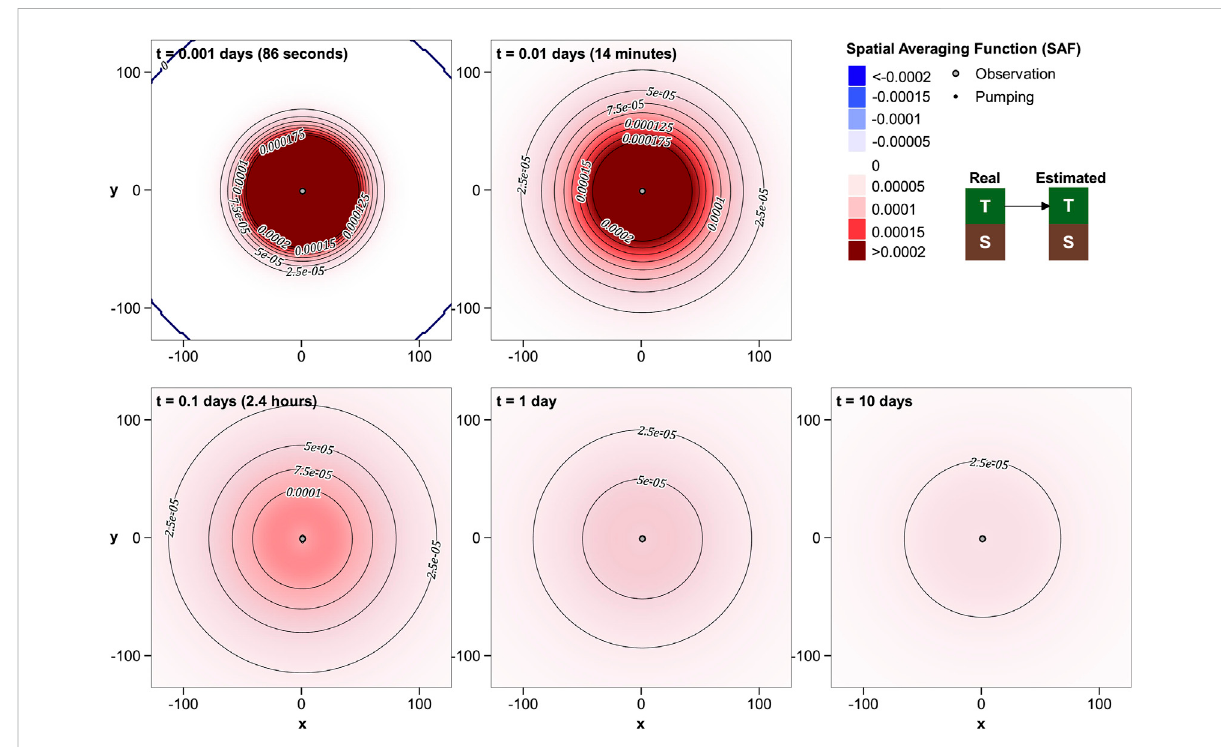
FIGURE 11 R ′ T − T for near-coincident wells at fi ve different